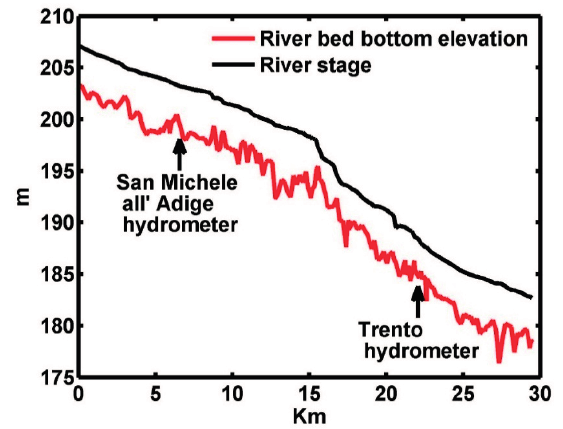
Figure 3. Riverbed bottom elevation for the Adige River and the river stage computed with variable water discharge along the course equal to the mean recorded during the period 23 to 25 June